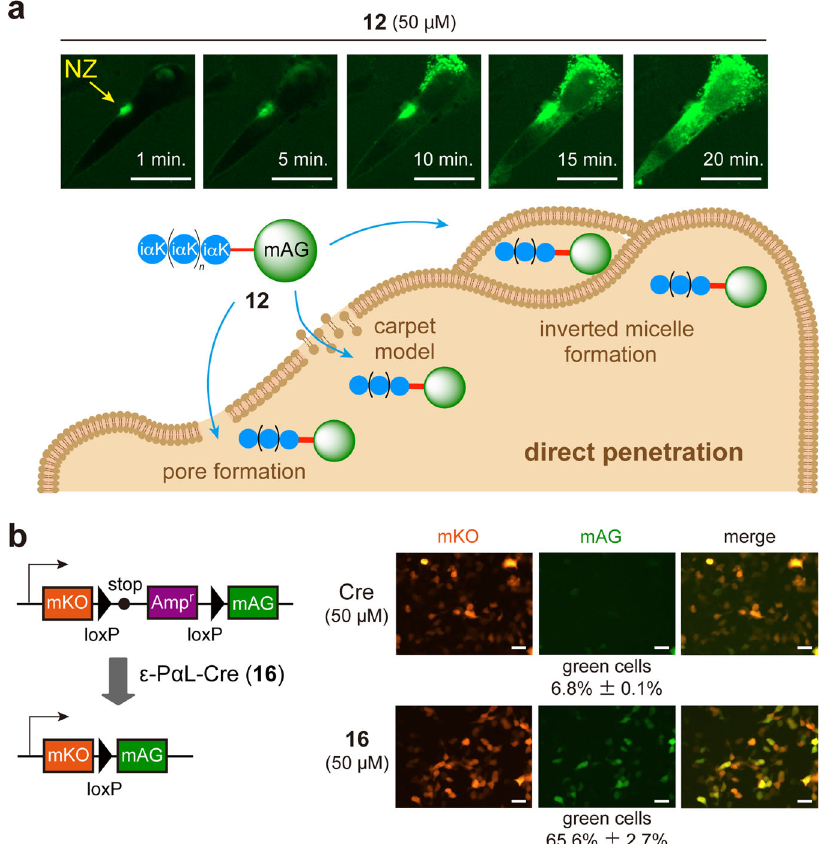
Fig. 5 Cytosolic deliveries of protein cargoes conjugated with ε -P α L. a Time-lapse experiment showing the cellular uptake of 12 . The time-lapse imaging showed HeLa cells with CM after the addition of 12 at 37 °C. After 1, 5, 10, 15, and 20 min, the snapshot images are shown (see also Supplementary Video 1). NZ, nucleation zone. Scale bars, 20 µ m. The proposed direct penetration mechanisms are schematically shown (bottom). b The Cre activity reporter plasmid constructed in this study is schematically shown. The reporter plasmid expressed a fusion fl uorescent protein (mKO-mAG) and mKO alone in HeLa cells with and without Cre recombinase, respectively. HEK293T cells were transfected with the reporter plasmid and were then incubated for 24 h at 37 °C. The cells were treated with Cre recombinase (50 μ M) or ε -P α L-Cre ( 16 ) (50 μ M) for 60 min at 37 °C after con fi rming the mKO expression. Cells were incubated for 24 h under typical culture conditions after washing. The gene recombination event by 16 was monitored by microscopy. The representative microscopy images are shown. The gene recombination ratios are presented as the mean ± s.d. ( n = 3). Scale bars, 20 µ